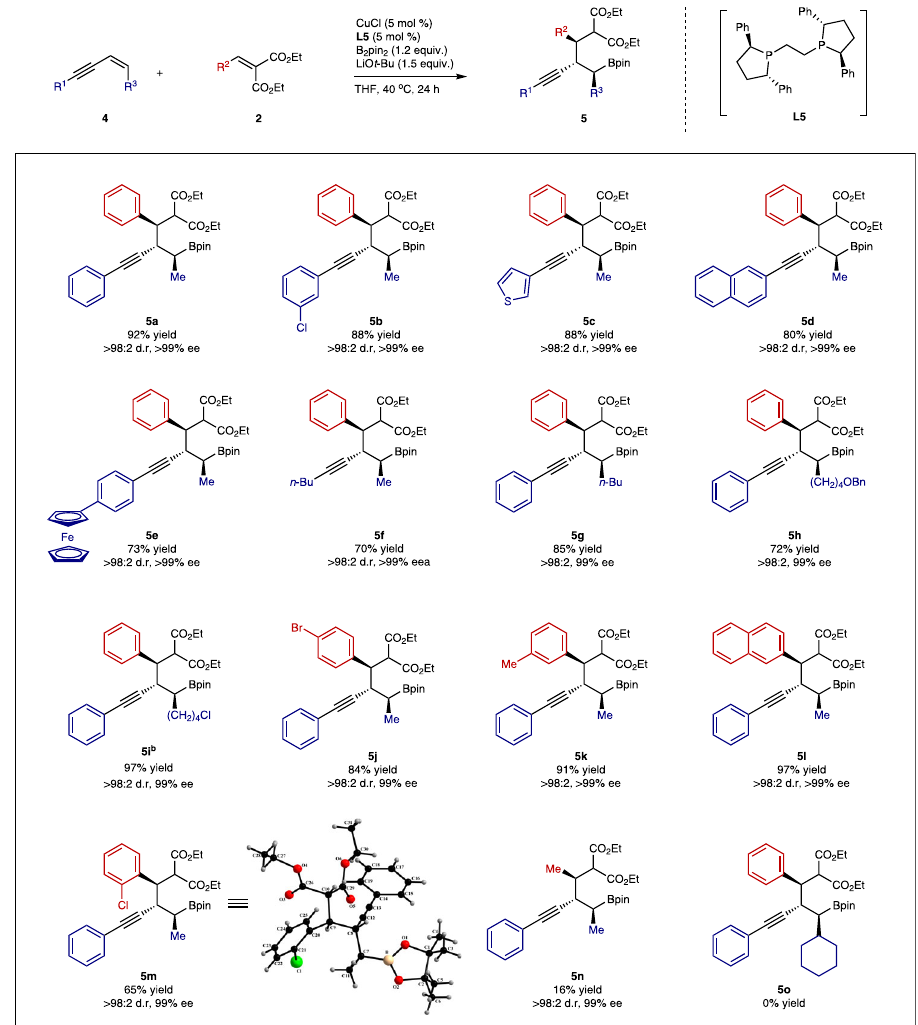
Fig. 4 Substrate scope of internal enynes. Reactions were generally conducted in a 0.5 mmol scale using 4 (1.2 equiv.) and 2 (1.0 equiv.) with the L5 - copper catalyst at 40 °C unless otherwise noted. a %ee was determined with 6 f . b MTBE was used as